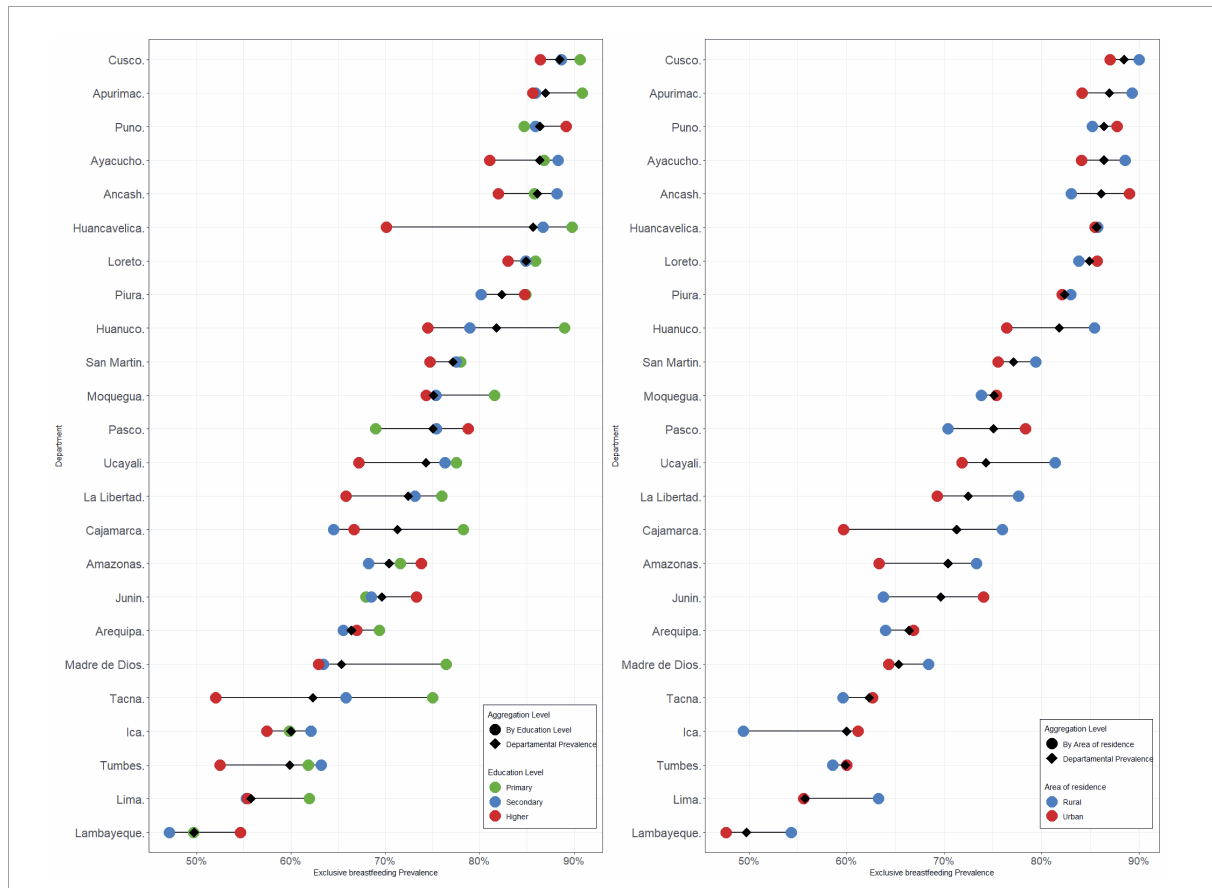
FIGURE1 Prevalence of exclusive breastfeeding (EBF) by department and socioeconomic